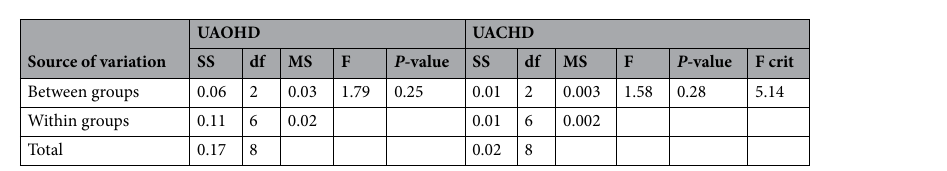
Table 4. ANOVA of the quantity of extracted EO of lemongrass through UAOHD and UACHD. Where SS sum of square, MS mean sum of square, df degree of